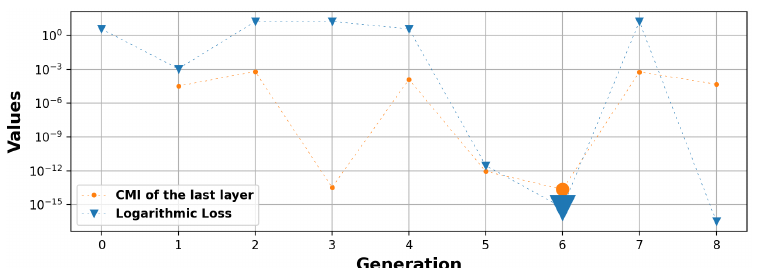
Figure 6: Log loss and CMI-based values for the last layer versus different generation. These values are obtained for the best genome at each generation. For better readability, the results for one randomly selected class from ASCAD fixed sync dataset is presented. Note that if the CMI-based criterion has not been considered, the learning might have been stopped in generation 3, where the fitness (log-loss) value does not decrease; however, the reduction in the CMI indicates that the model is still learning. Dashed lines are drawn for the sake of readability.